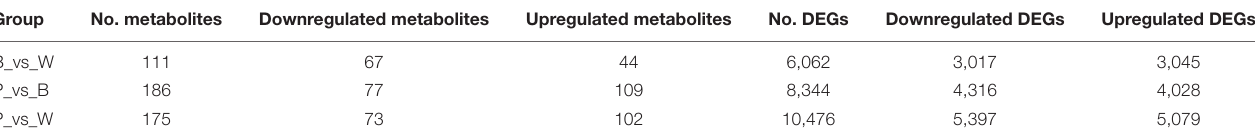
TABLE 1 | Statistical classification of differentially expressed metabolites and